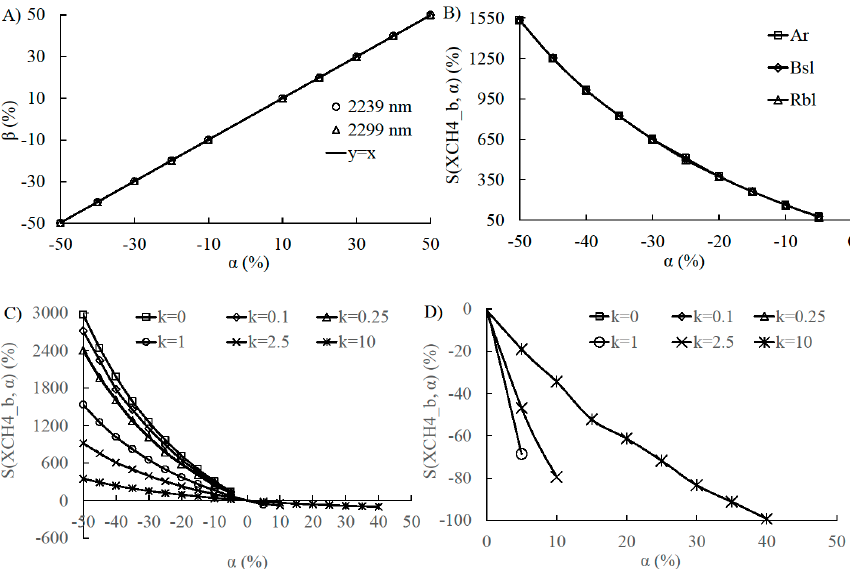
Figure 6. ( A ) Relative error ( β ) in at sensor radiance ( L t ( λ )) with respect to the relative surface albedo error ( α ) and 1:1 line (solid). ( B ) Relative methane column, XCH 4 , sensitivity, S (XCH 4_b , α ) with respect to α for the three land cover types, Ar, Bsl, Rbl, which are for Asphalt road, Brown sandy loam, and Reddish brown sandy loam, respectively. XCH 4 _ b is for the observed plume ( k = 1) in all simulations. ( C ) S (XCH 4_b , α ) for pixel Rbl with different plume strength cases defined by k , see Equation (4). ( D ) Expanded view of ( C ) for positive α .